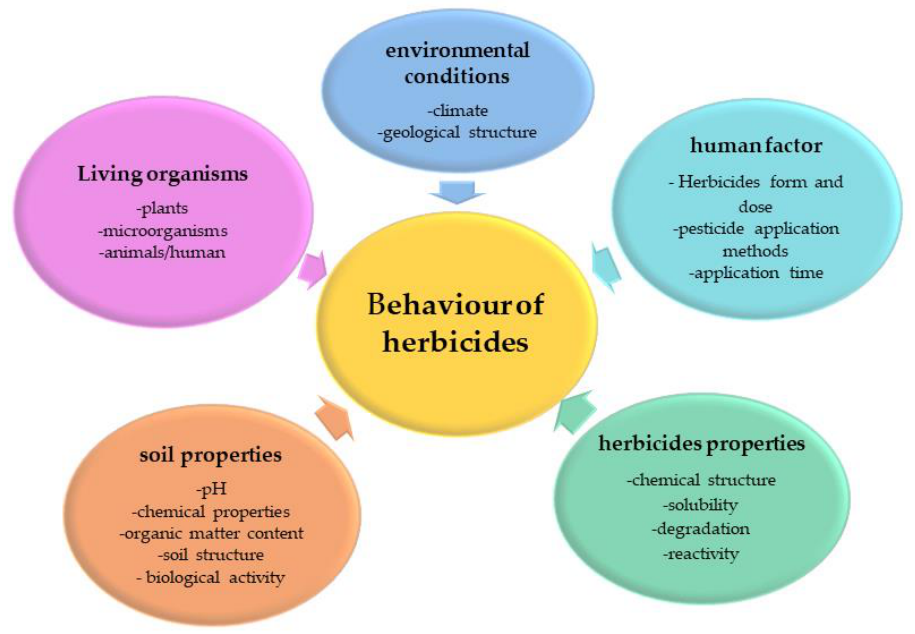
Figure 3. Factors affecting the behavior of herbicides in the environment.